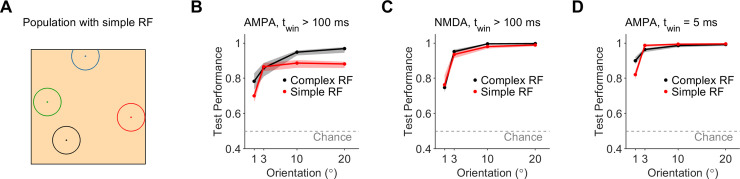
Performance of edge-orientation classifiers that integrated over neurons with a simple receptive field.A. Example receptive fields of four neurons from the population of first-order neurons, each of which innervated a single mechanoreceptor (see Methods). The patch of skin had dimensions as in Fig 2. B. Comparison of the test performance of classifiers that performed edge-orientation discrimination using synaptic integration over first-order neurons with a complex receptive field (multiple mechanoreceptors, black) or a simple receptive field (single mechanoreceptor, red). Classifiers used fast-decaying (AMPA) synapses, and were given a long (> 100 ms) stimulus presentation time window and a noise level of 5%. C. Same as B, but for classifiers using slow-decaying (NMDA) synapses. D. Same as B, but for a short (5 ms) stimulus presentation time window.